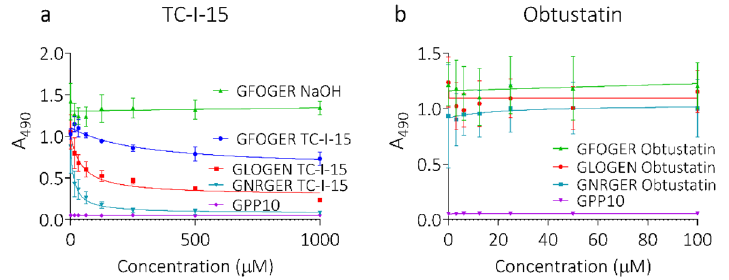
Figure 3. Inhibition of HUVEC adhesion to collagen mimetic peptides using TC-I-15 and Obtustatin. Dose curves for TC-I-15 ( a ) or Obtustatin ( b ) inhibition of HUVEC adhesion to THPs; GFOGER (blue), GLOGEN (red), GNRGER (turquoise) and GPP10 (purple). Cell adhesion is quantified as A 490 . GFOGER NaOH (A— green) shows HUVEC adhesion to GFOGER in the presence of the TC-I-15 vehicle control. For clarity, the vehicle control data was not shown for the other peptides. Error bars indicate SEM calculated from three repeats performed in